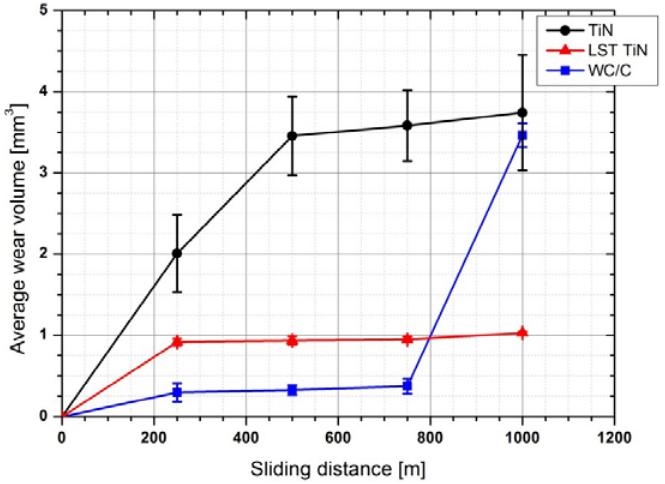
Figure 9. Average wear volume versus sliding